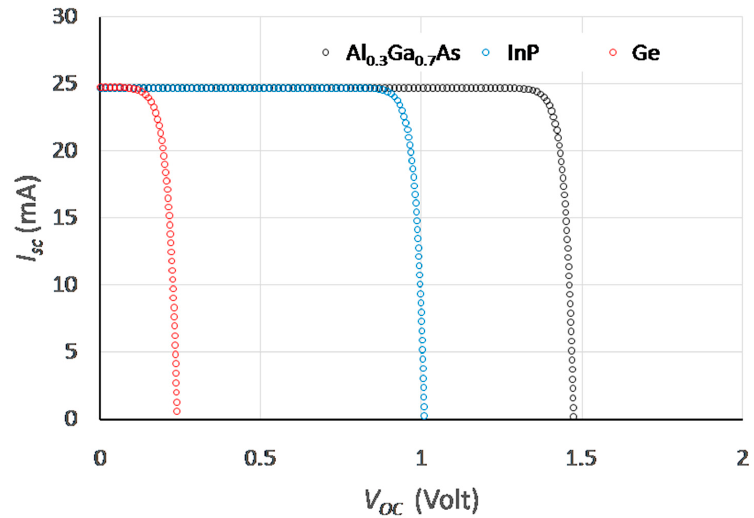
Figure 5. The electrical performance of Al 0.3 Ga 0.7 As / InP / Ge TJSC at geosynchronous of Earth. All subcells were connected in a series and possess the same current.